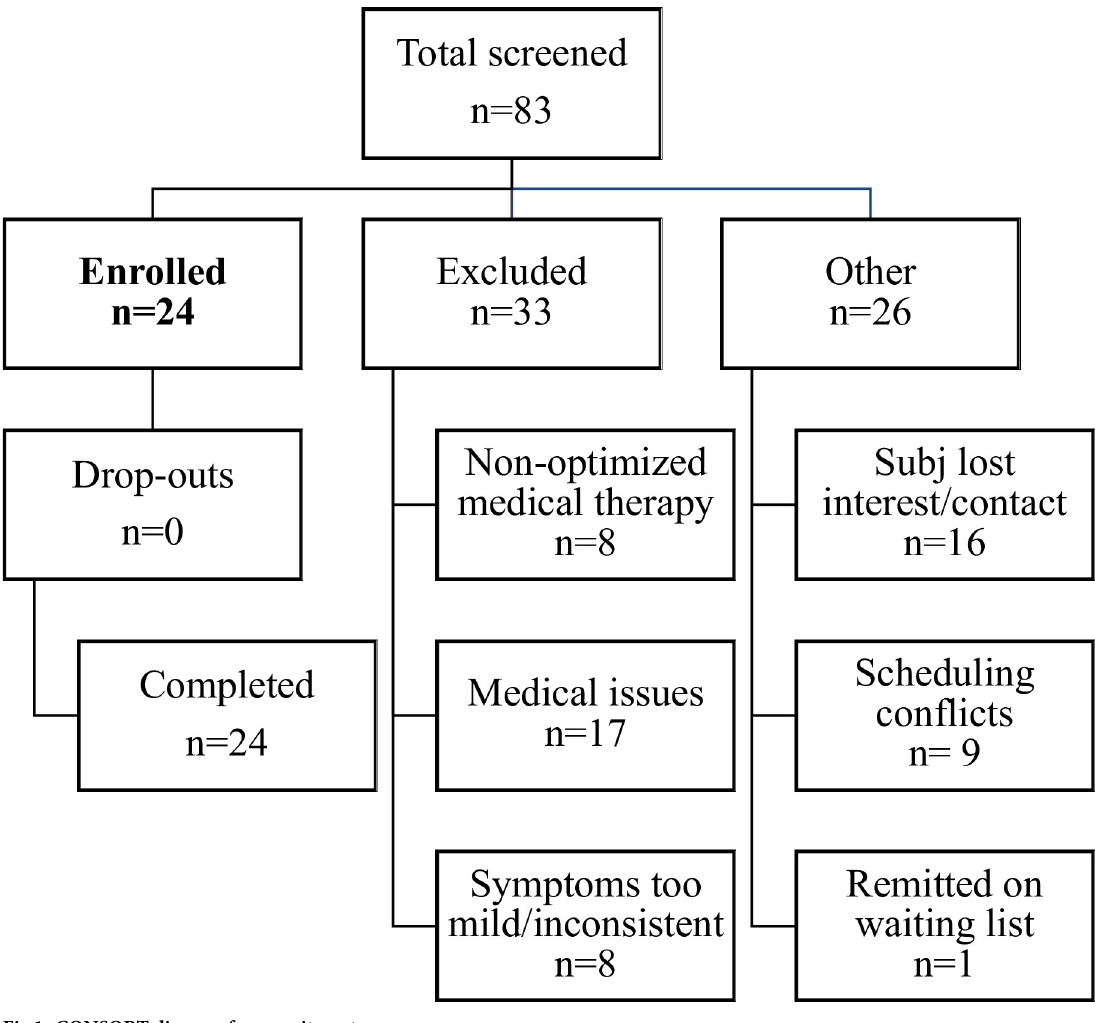
Fig 1. CONSORT diagram for